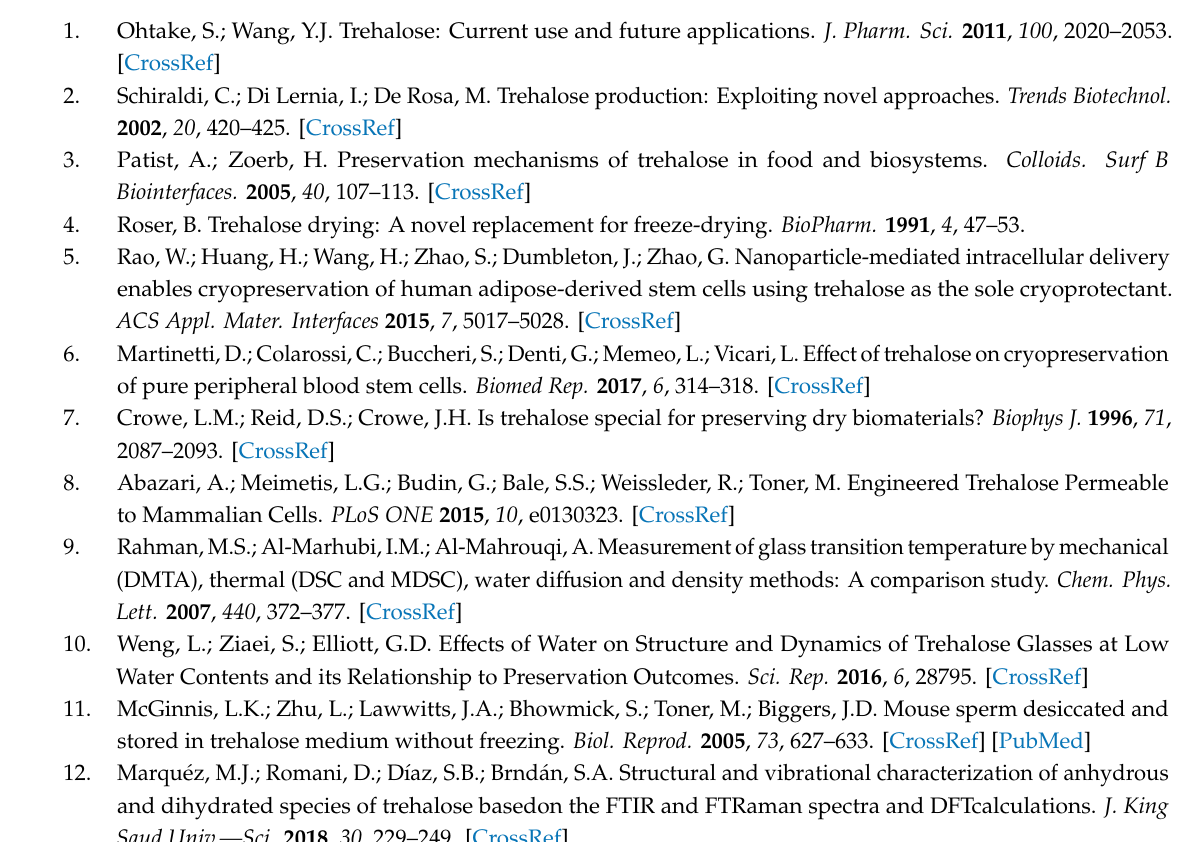
Supplementary Materials: The Supplementary Materials are available online. This section includes: Table S1 (description of systems used for molecular dynamics simulations); Table S2 (force field parameterizations used along this work); Figure S1 (comparison of trehalose